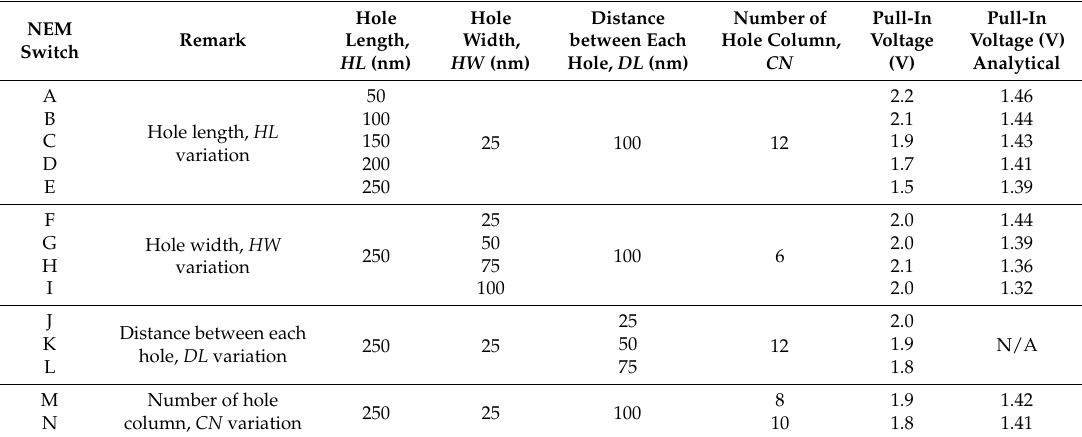
Table 3. Dimensions of the perforated graphene-based NEM switch with variation of hole length ( HL ), hole width ( HW ), distance between two holes ( DL ), and number of hole column ( CN